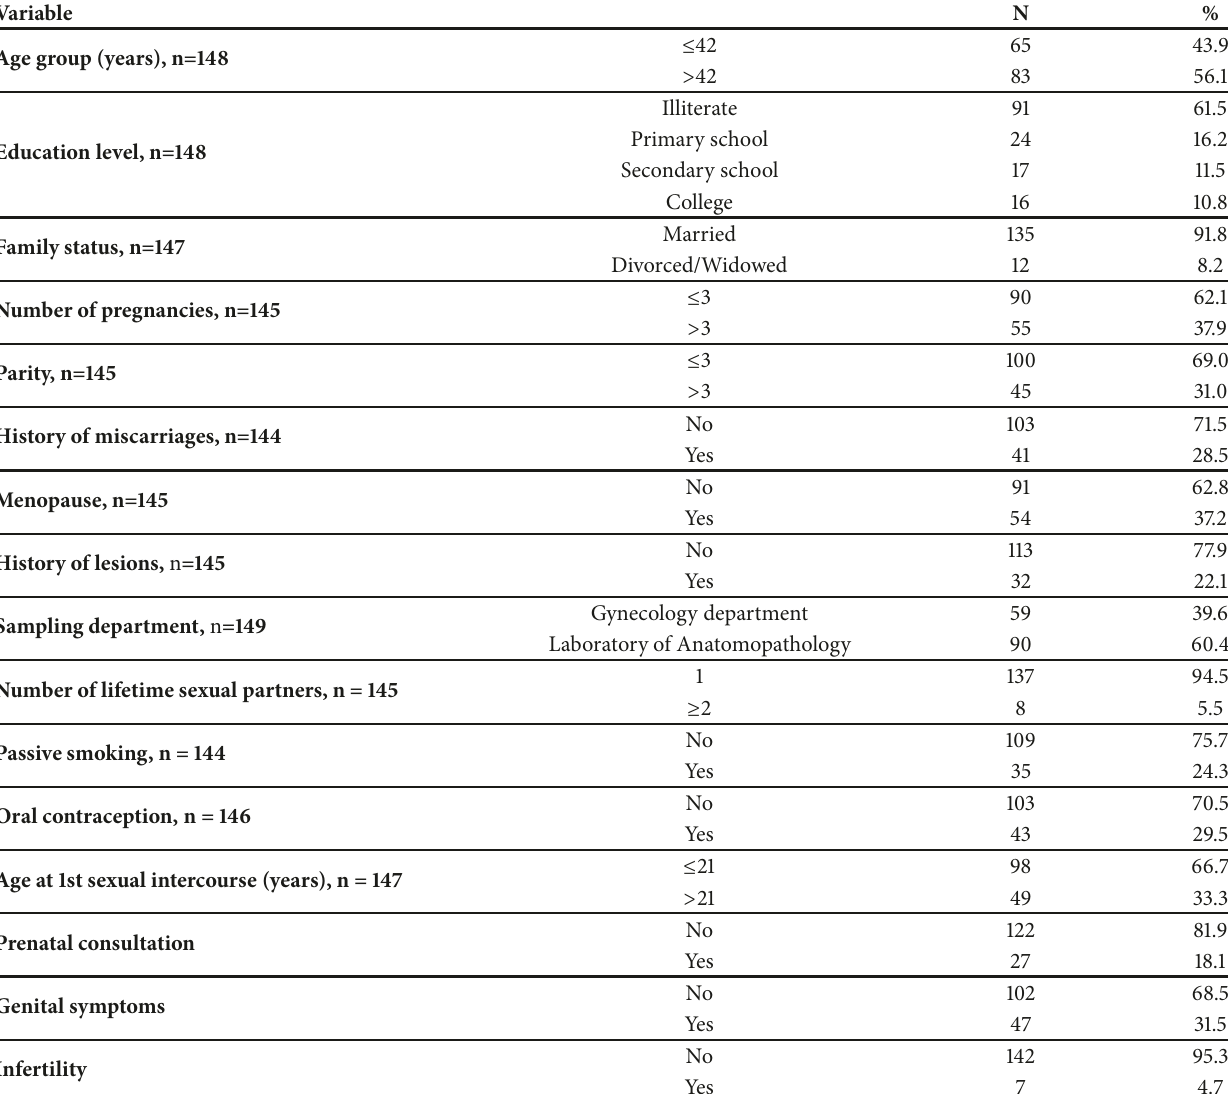
Table 2: Demographics and clinical characteristics of the studied